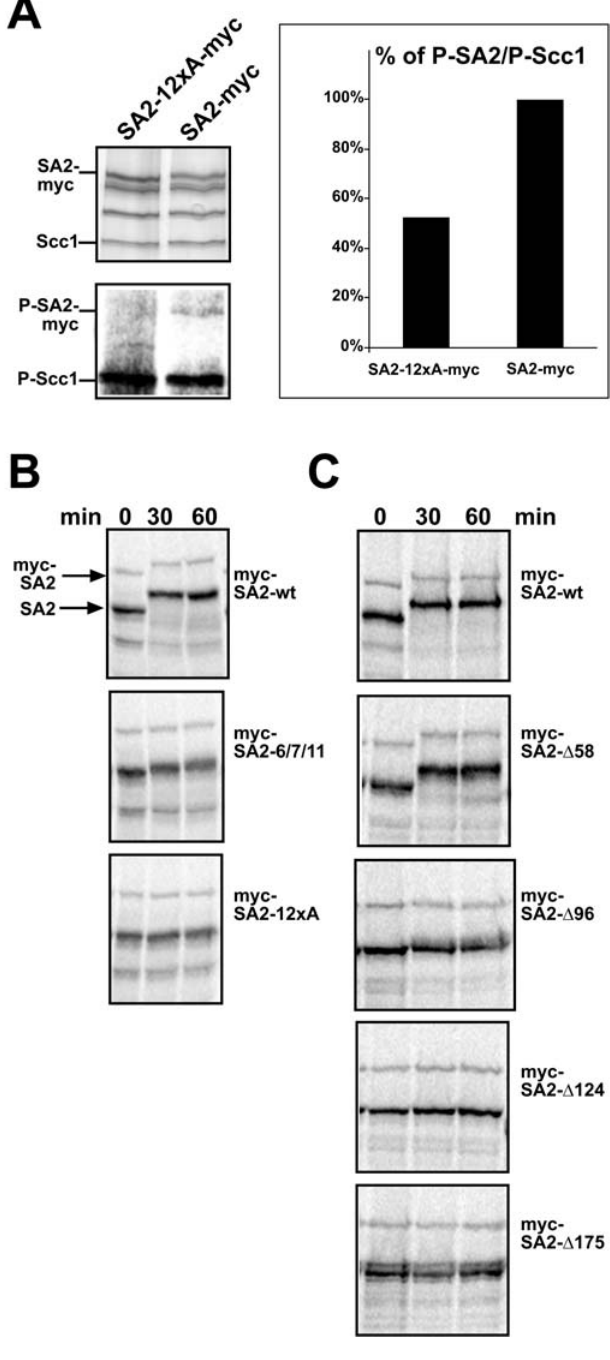
Figure 4. Mutations of the C-Terminal Phosphorylation Sites and C- Terminal Deletions Decrease the Mitotic Phosphorylation of SA2 (A) Cohesin complexes containing wild-type SA2-myc or SA2–12xA- myc were immunopurified by myc antibodies from the respective cell lines. Similar amounts of cohesin were incubated with recombinant GST-Plk1, and the amount of phosphorylation was quantified by 32 P incorporation followed by SDS-PAGE, silver staining (top) and Phosphorimager analysis, and quantification using the software program ImageJ. (B and C) In vitro-translated, 35 S-labeled SA2 tagged at the N terminus with 9xmyc was incubated in interphase Xenopus egg extracts, which were induced to enter mitosis at time point 0 min by addition of nondegradable cyclin B D 90 and okadaic acid. Samples were collected at the indicated time points and analyzed by